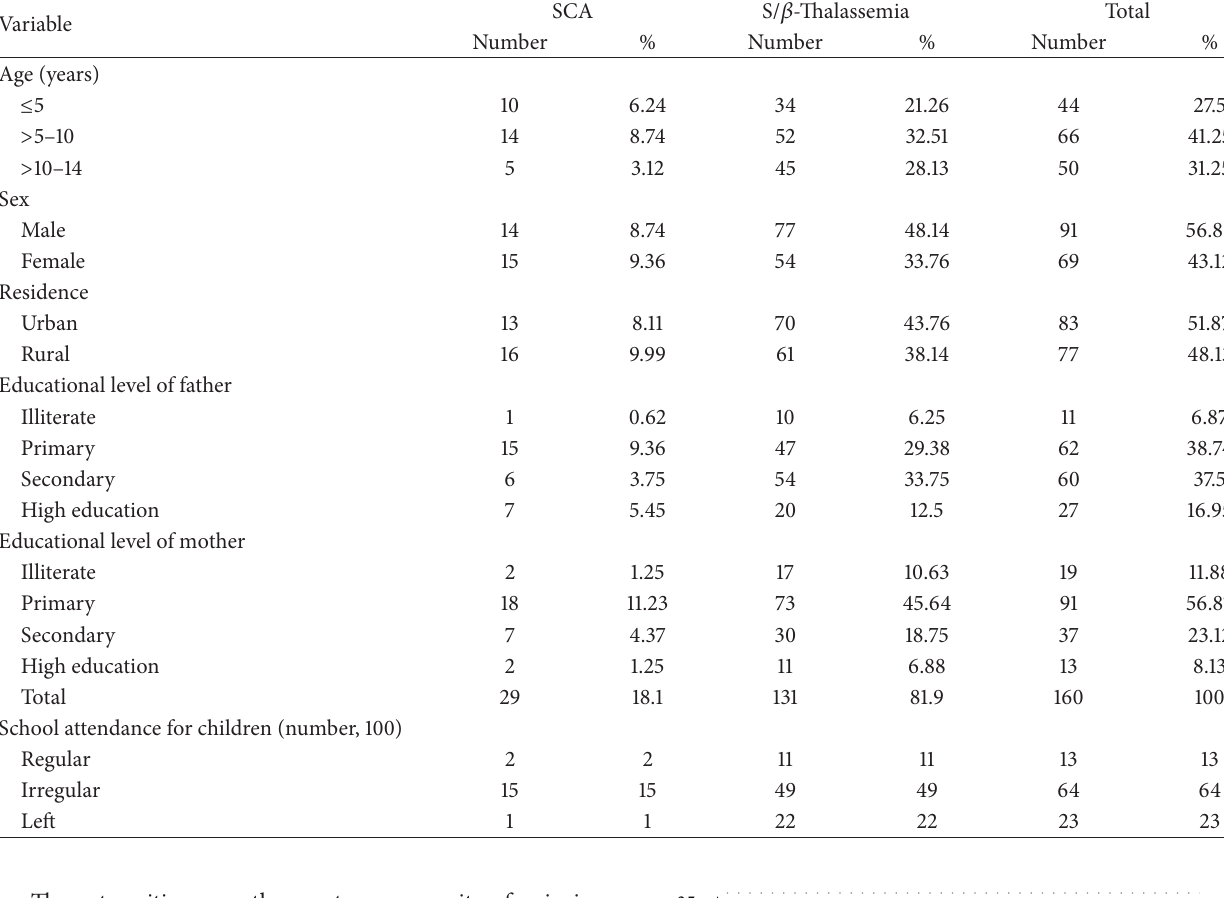
Table 1: Selected sociodemographic characteristics of patients.